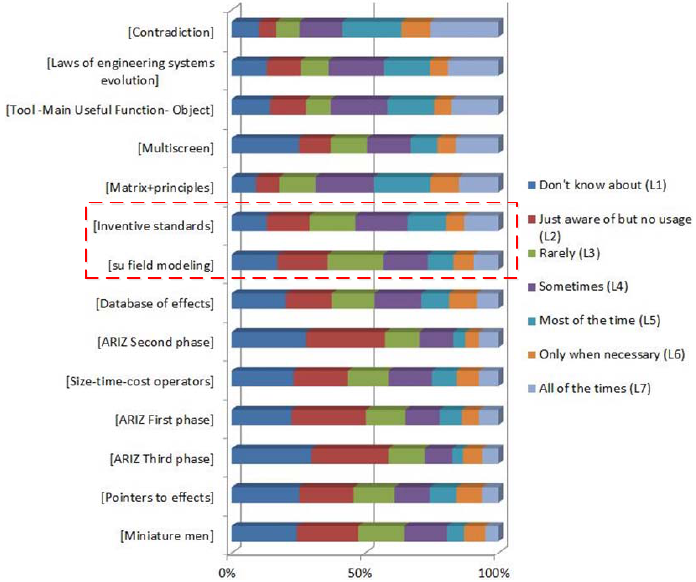
Figure 1. The frequency of TRIZ’s main